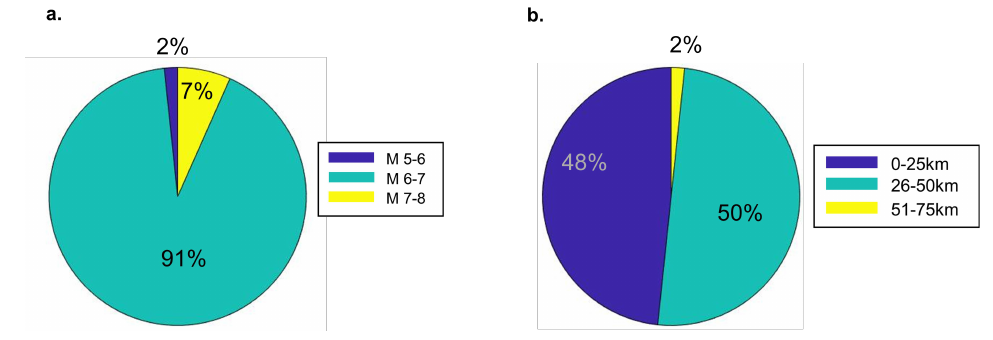
Figure 3. ( a ) Magnitude and ( b ) distance of Set-2 (ground motions from